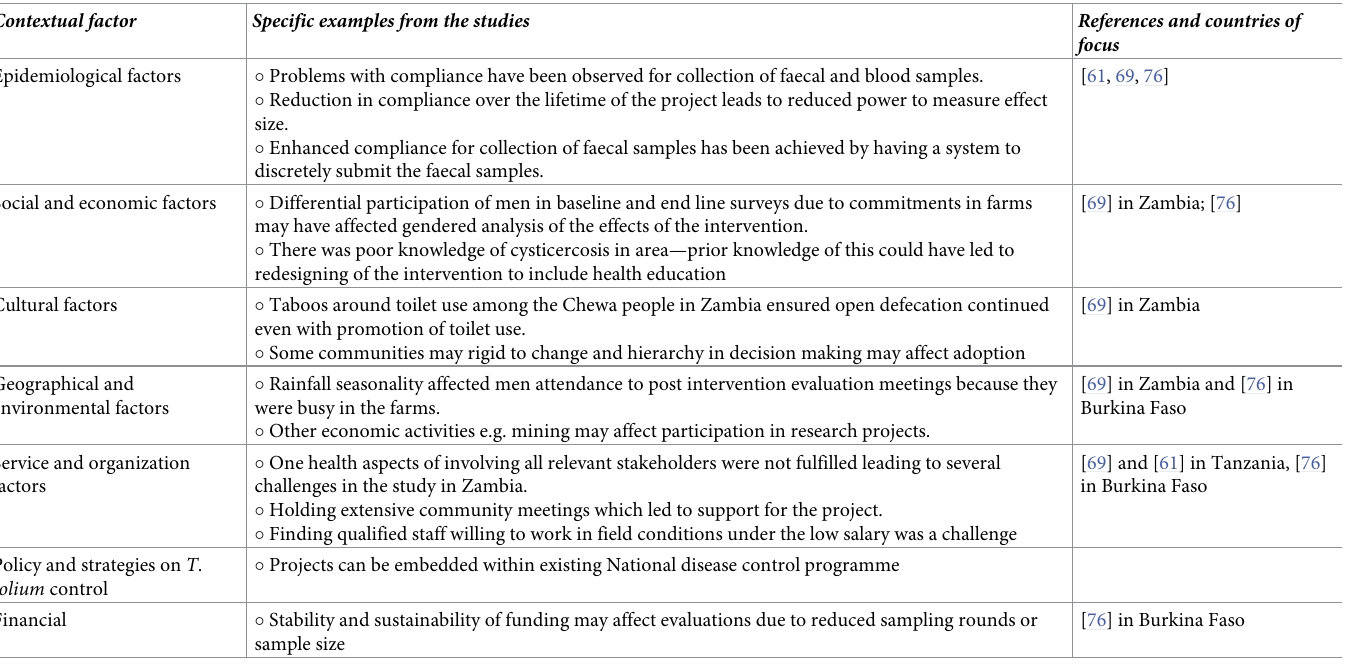
Table 4. Summary of contextual factors analysis for scale-up